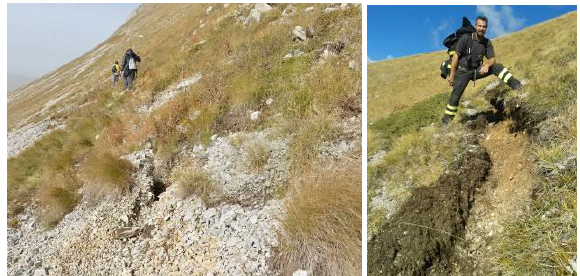
Figure 1. The Fault of Mt. Vettore before the earthquake of Norcia (Left) and after (right)